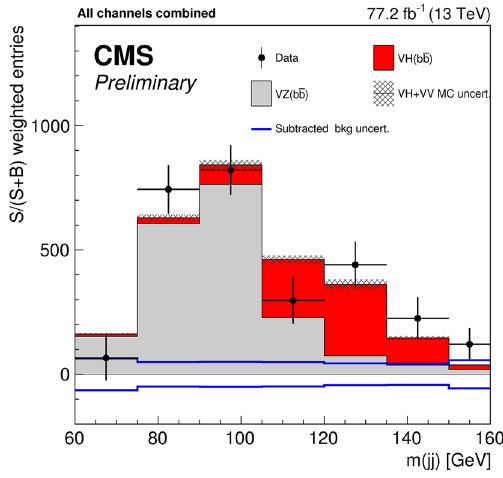
Fig. 3 Weighted bottom anti-bottom quark invariant mass data from CMS for ∼ 77 . 2 fb − 1 [27]. The plot includes all final states with 0, 1 and 2 leptons and it compares the data yield with the SM expectation of H → b ¯ b and the SM expectation of Z → b ¯ b